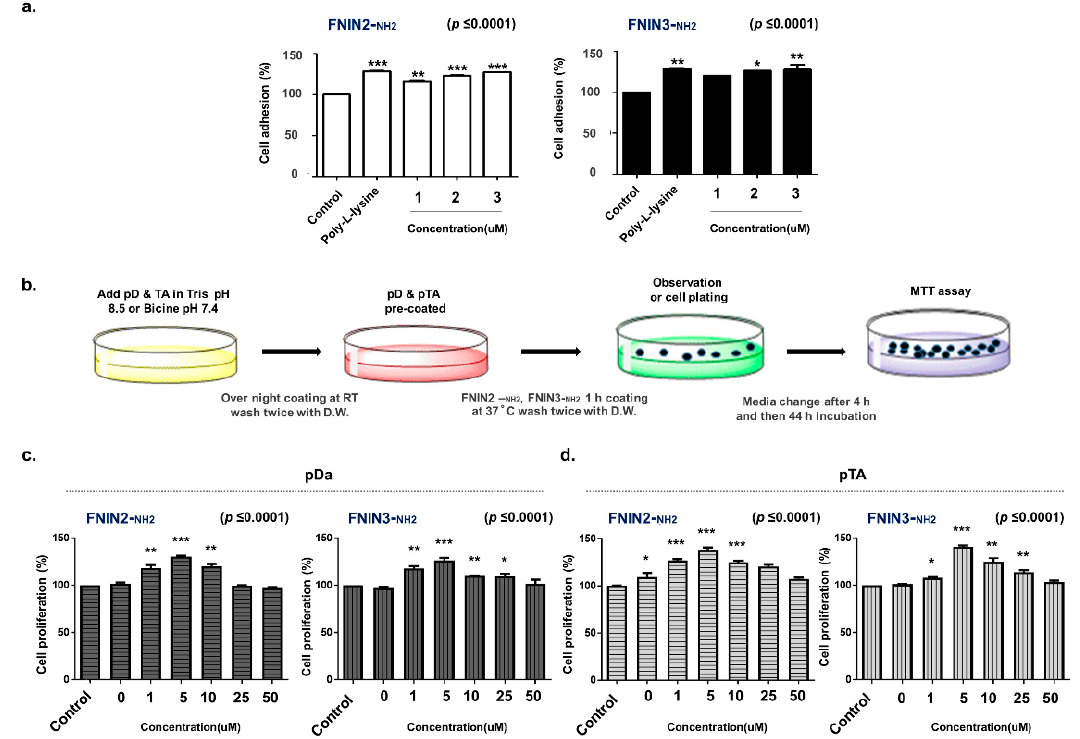
Figure 4. Effects of FNIN2- NH2 and FNIN3- NH2 on cell adhesion and proliferation. ( a ) HBEpiC cell adhesion on FNIN2- NH2 , FNIN3- NH2 , or poly-lysine coated plates. ( b ) Schematic of the coating method used. ( c , d ) Cell proliferations on FNIN2- NH2 or FNIN3- NH2 after pTA or pD pre-coating. Means ± SD ( n > 3). * p ≤ 0.05, ** p ≤ 0.001, *** p ≤ 0.0001.